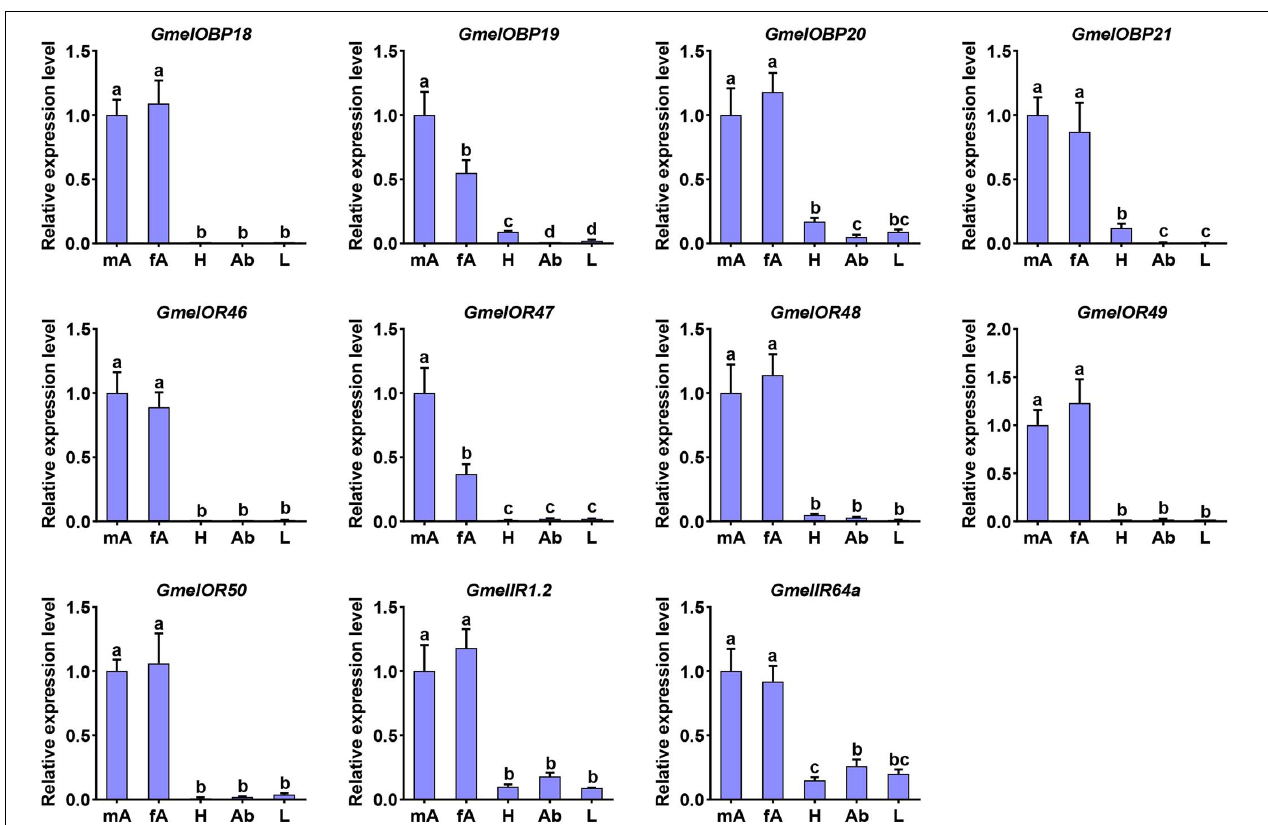
FIGURE 10 | Expression profiles of olfactory genes in different adult tissues. mA: male antennae, fA: female antennae, H: head (without antennae), Ab: abdomen, L: legs. Gene expression levels in various tissues were normalized relative to that in male antennae (set as onefold). Data are presented as mean ( n = 3) ± SE. Different lowercase letters indicate significant differences ( p < 0.05, one-way ANOVA with Tukey’s